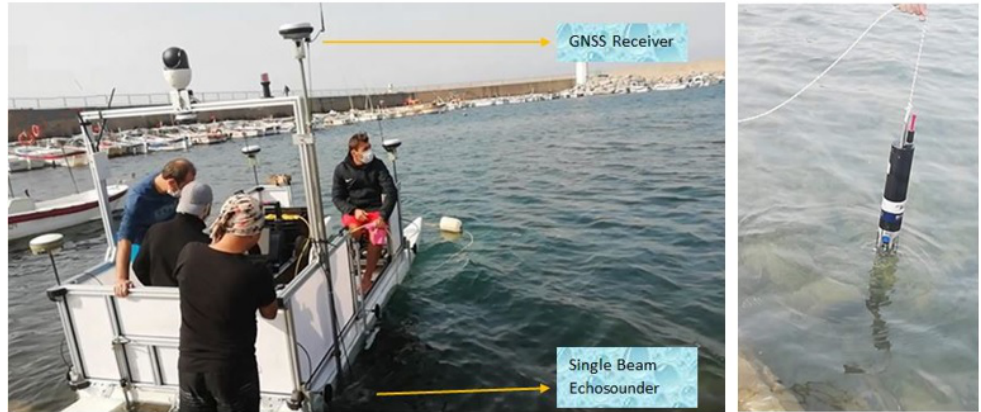
Figure 15. Sea-surface vehicle integrated with measurement devices used in the experiment, and the measurement of the acoustic sound velocity in the sea before the experiment ( right